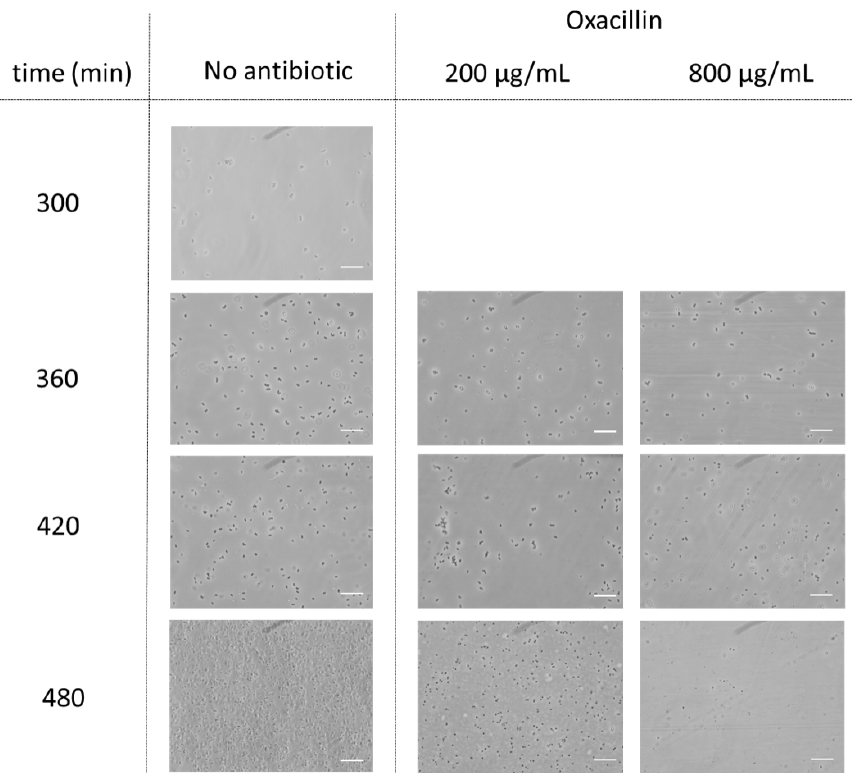
Figure 3. Optical microscopy images of S. aureus strain COL grown in the absence (left panel) and in the presence of different concentrations of oxacillin (Oxa) at 200 and 800 µg/mL (right panel), added at 300 min of growth. For each aliquot a calibrated volume of sample of 5 µL was collected and observed. An average of 10 photos were taken randomly at specific growth times: 0, 300, 360, 420 and 480 min. S. aureus are coccoid shaped cells with an average diameter of 0.5–1 µm. Scale bar represents 10 µm width.